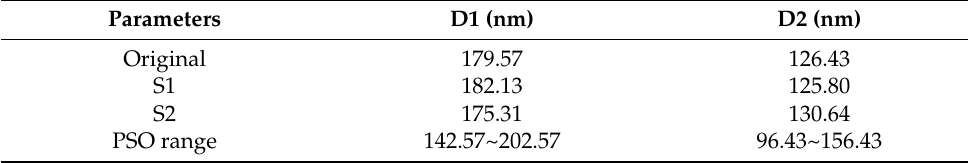
Table 4. The structures obtained by NN-PSO for the Bragg case in Figure